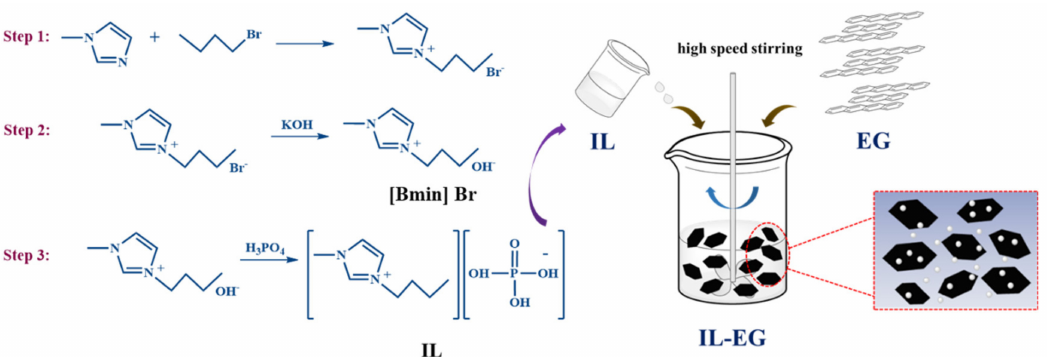
Figure 2. The synthesis route of IL and the illustration of the fabrication of the IL-EG.